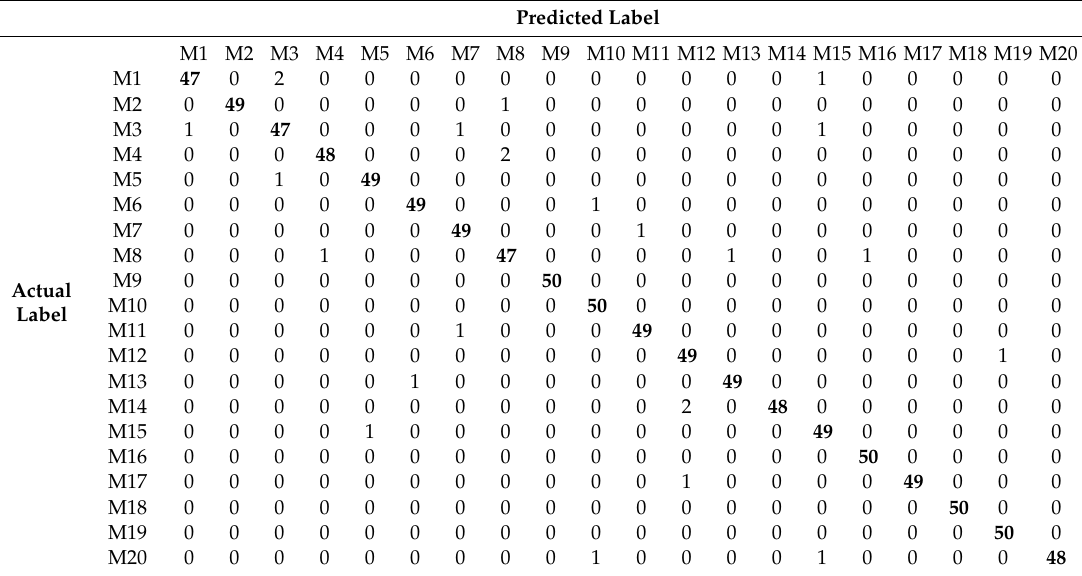
Table 2. The classification result of the LSTM on the single participant. Predicted